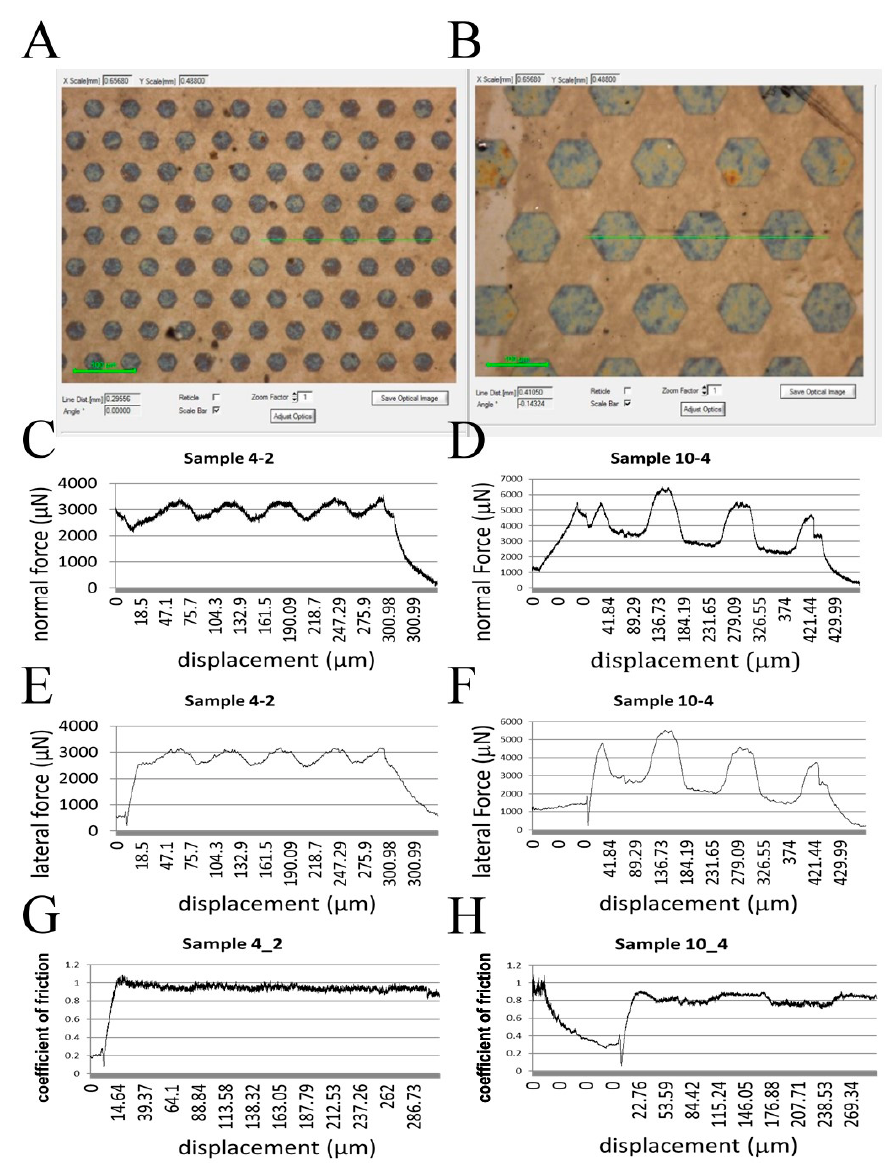
Figure 5. Comparison of normal forces, lateral forces, and coefficient of friction between micropillars of sample 4_2 and sample 10_4. The arrangement and size of the micropillars from sample 4_2 ( A ) and sample 10_4 ( B ). The normal forces ( C , D ), lateral forces ( E , F ), and coefficient of friction ( G , H ) were obtained during the scratch test. As shown in panel G, sample 4_2 shows a higher coefficient of friction than sample 10_4.